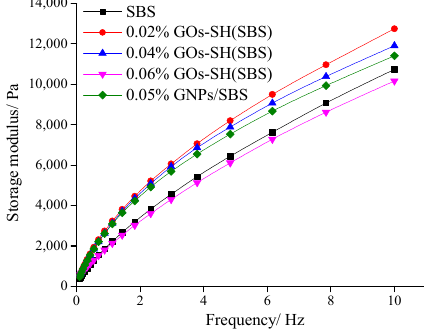
Figure 5. Effect of GOs-SH content on G ′ as a function of shear frequency at 64 °C.